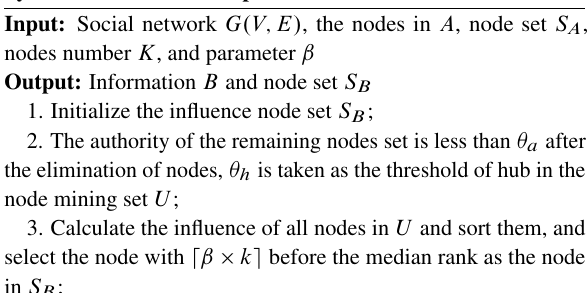
Algorithm 2 Influence maximization algorithm based on dynamic network in competitive environment